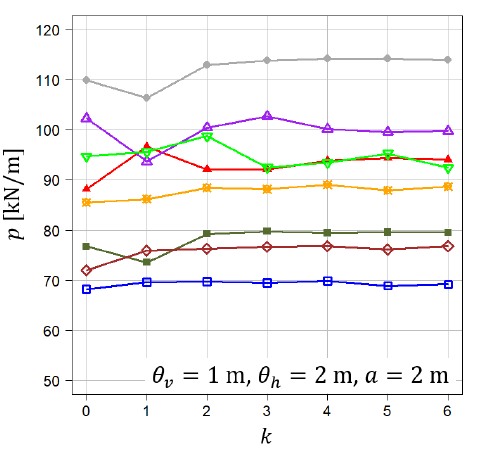
Figure 3: Eight randomly selected results among 200 Monte Carlo realizations for the case of θ